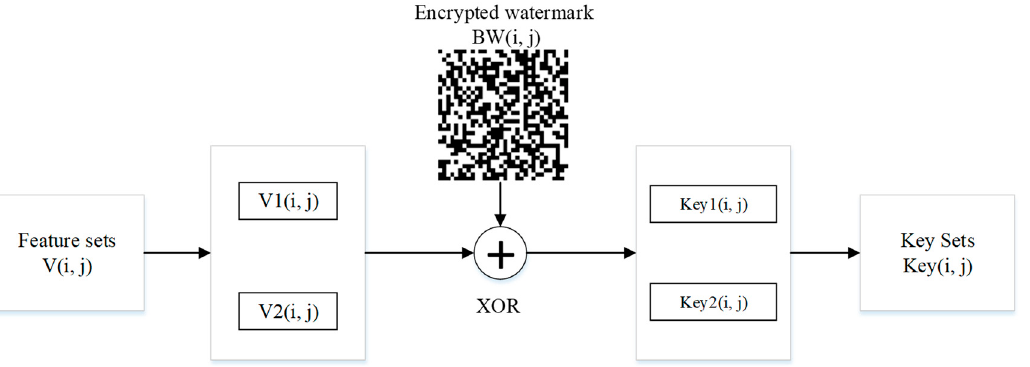
Figure 8. Flow chart of embedding watermark.